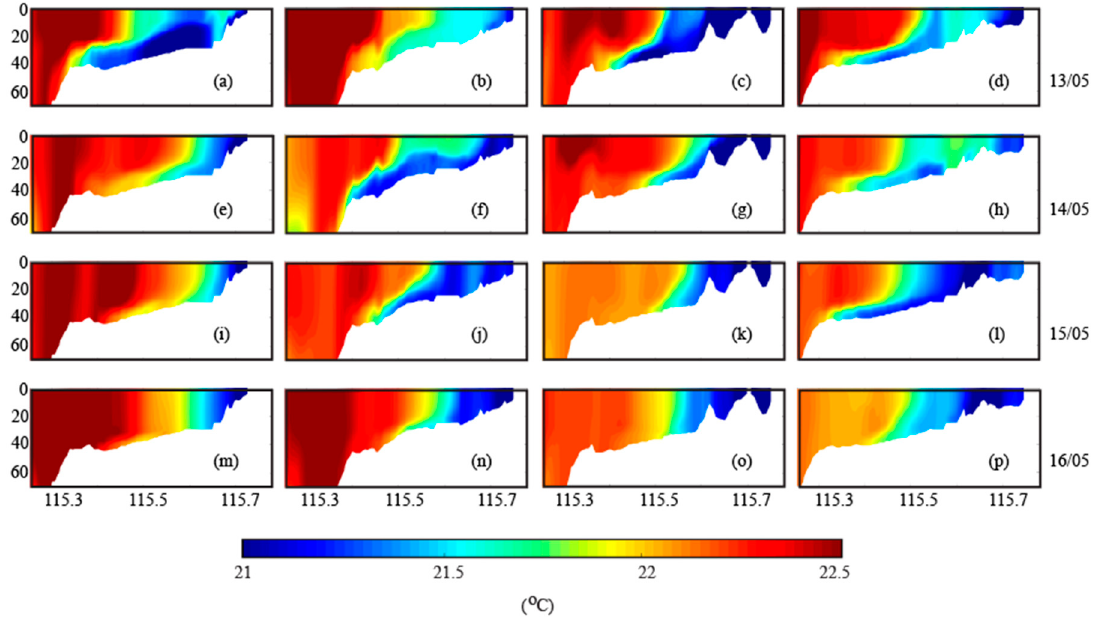
Figure 10. Cross-shore transects during low to moderate wind conditions (May 13–16, 2016) for four different latitudinal locations: ( a , e , i , m ) − 31.8° N (P2); ( b , f , j , n ) − 31.95° N (P3); ( c , g , k , o ) − 32.25° N (P4); and ( d , h , l , p ) − 32.44° N (P5). P1–P5 are related to flow pathways defined in Figure 8.